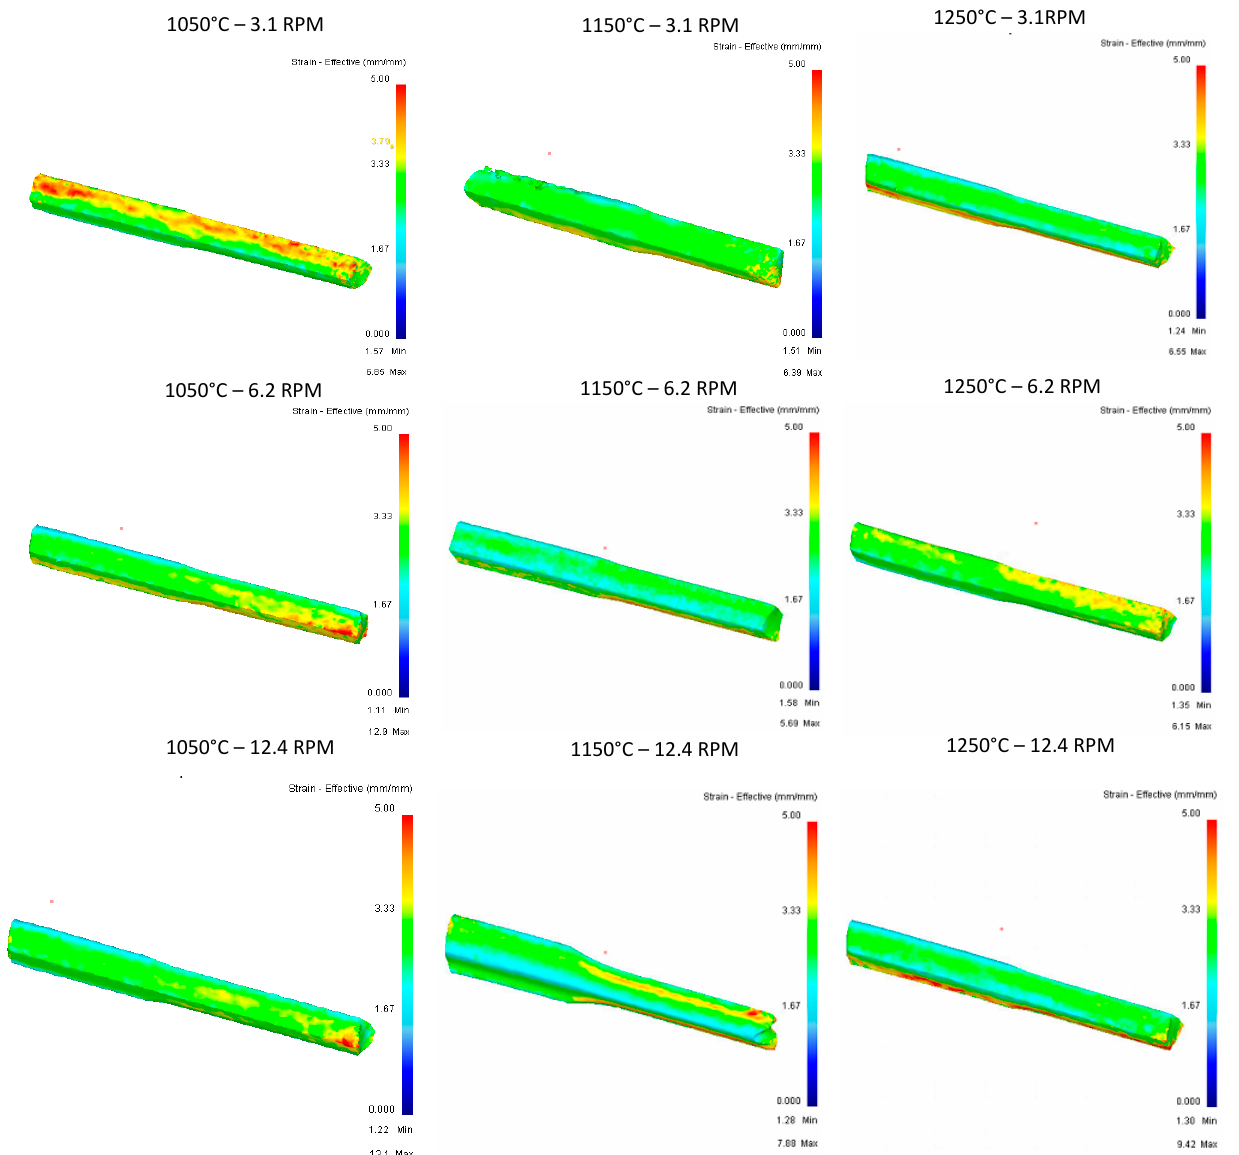
Figure 23. Effective Stress in the top Rail after fifth pass.